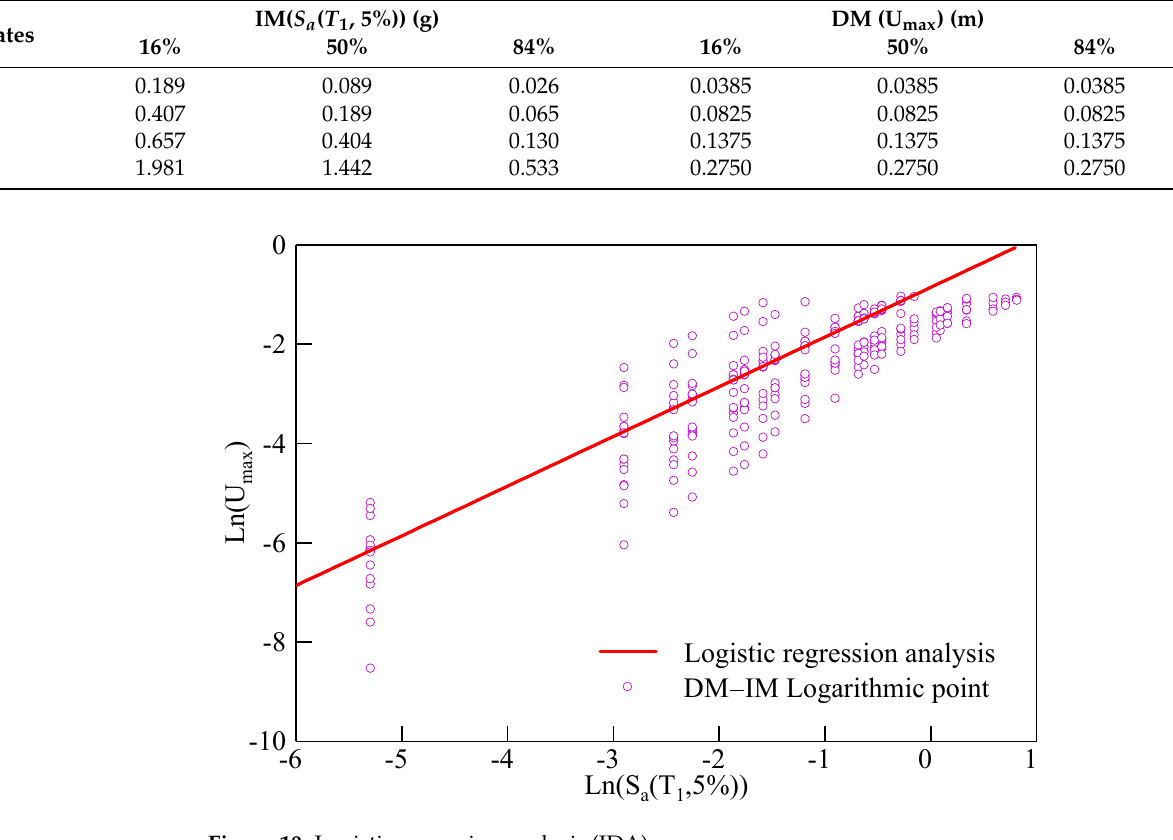
Figure 10. Logistic regression analysis (IDA).